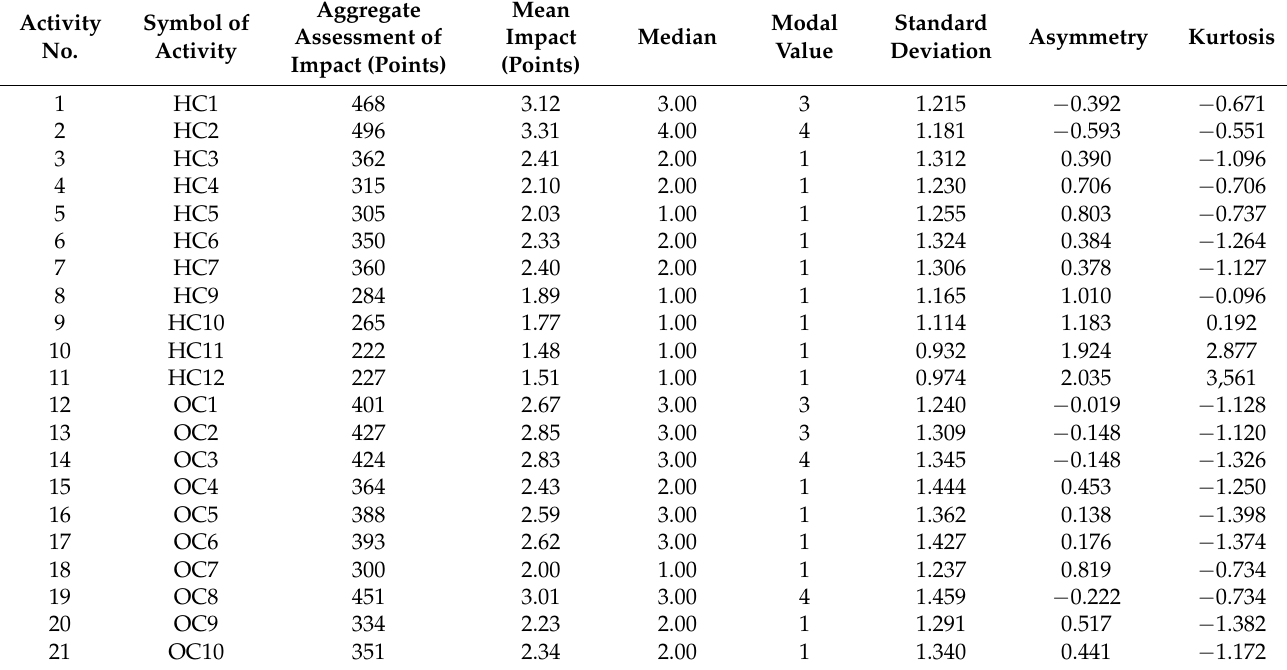
Table 3. TheimpactsofactivitiesfosteringGIContheenvironmentaldevelopmentofthestudied